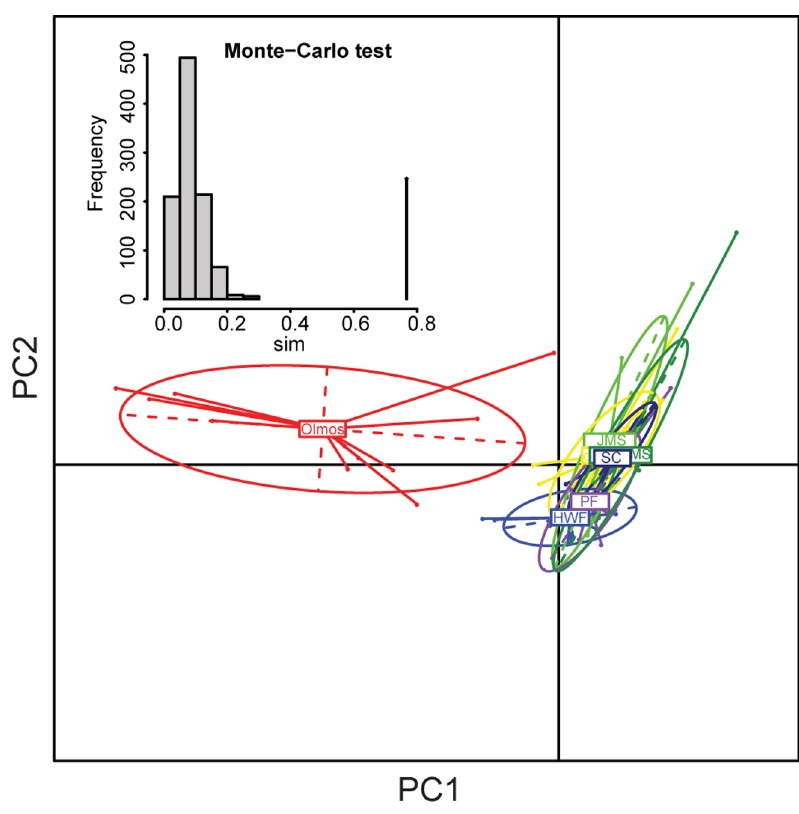
Figure 4. PCA plot portraying hydraulic strategies among communities. Between-Class principal component analysis showing ellipses and gravity centers for extant communities and the Olmos paleoforest. Wet tropical, dry deciduous and montane forest were not included in this analysis. The insert in the upper left corner is the histogram of 1000 simulated values for the between-groups PCA and the observed value (vertical line at sim=0.78). Sim = ratio of between class and total inertia. HWF= hardwood forest, JMS= juniper-mesquite savanna, MS=mesquite savanna, PF= palm forest, SC= sage scrub.